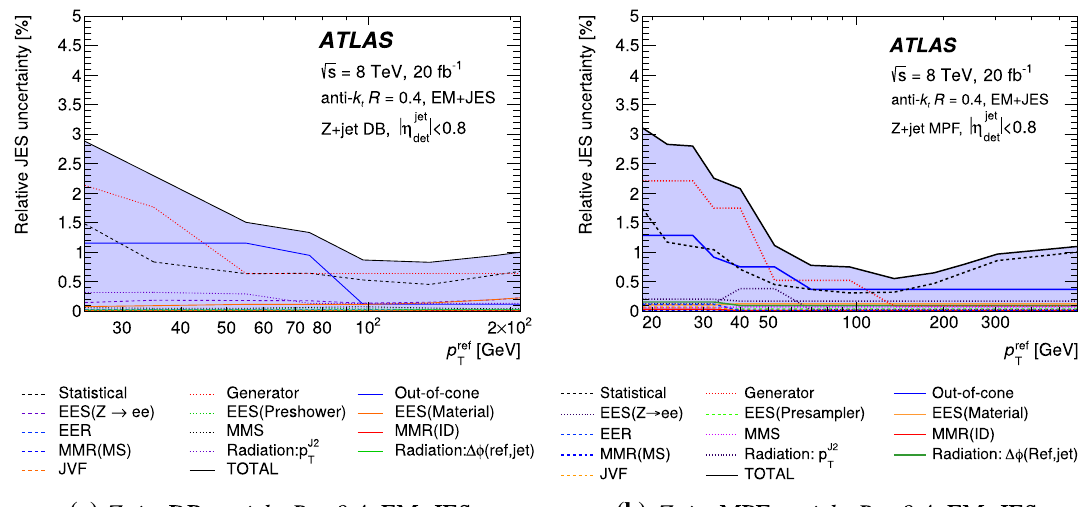
in quadrature of all uncertainty sources. EES/EER denotes the electron energy scale/resolution, while MMS/MMR denotes the muon momen-